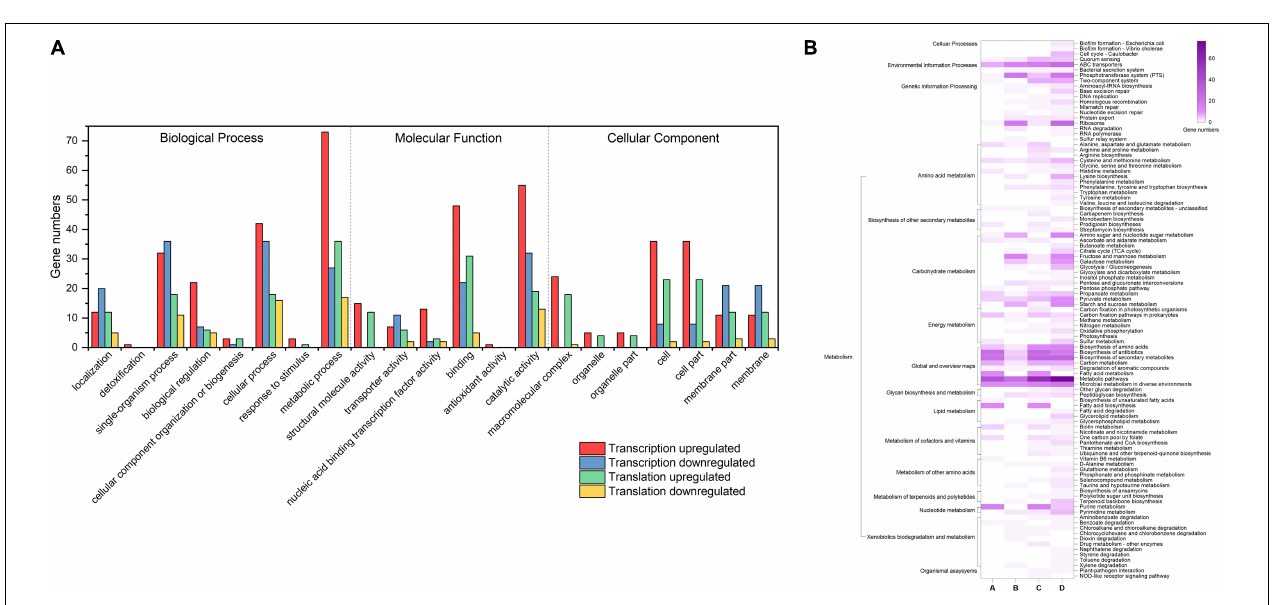
FIGURE 3 | (A) GO analysis of DEGs in OS and CG. (B) KEGG pathways of DEGs in OS and CG.